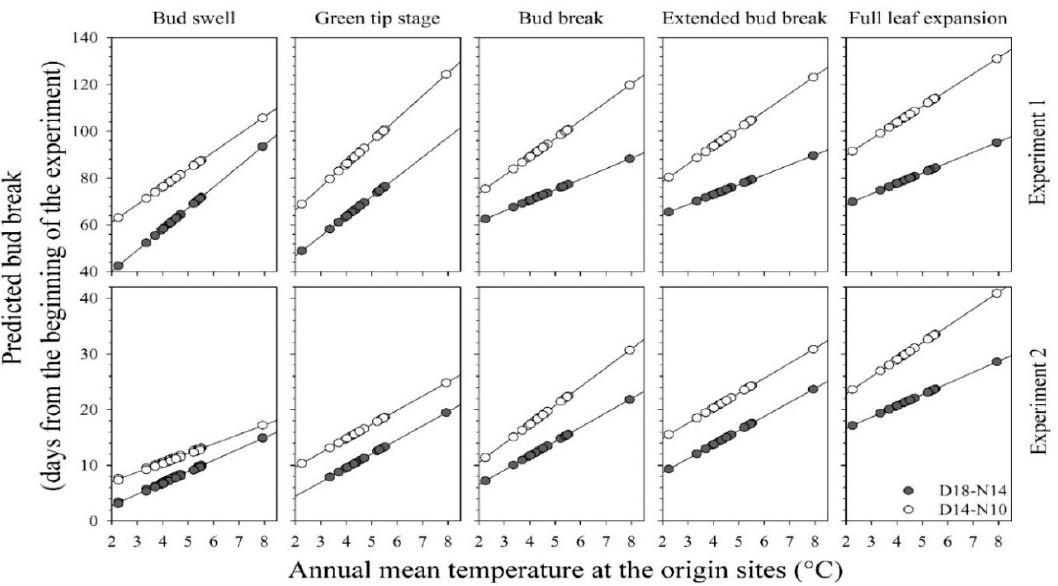
Figure 2. Days of occurrence of the five phases of bud break predicted for sugar maple by the linear mixed model (LMM) performed on data of the two experiments at control and warming treatments. Dots represent the different provenances. White and grey dots refer to day/night temperatures of 14/10 and 18/14 °C, respectively. The ranges of y -axis are different. Table 3. Linear mixed model (LMM) comparisons of the timing of each bud break phase (days from the beginning of the experiment) in sugar maple resulting from the two experiments using mean annual temperature at the origin site (TP), thermal treatment in growth chamber (TT), and their interaction as effects, as well as the least-squares mean (LS-mean) when a given phenological phase was observed at day/night temperatures of 14/10 (Colder) and 18/14 °C (Warmer), respectively. Three asterisks indicate p < 0.001. LS-Mean values bearing different letters within rows are statistically different at 0.05 probability.